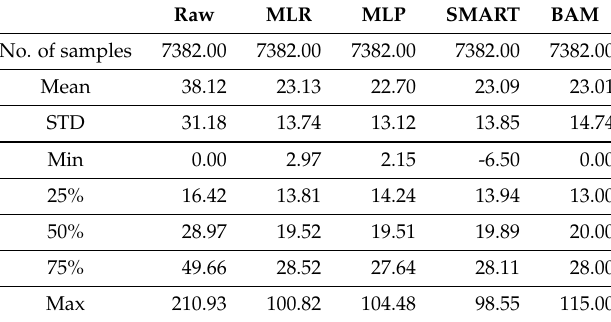
Table A4. Descriptive statistic summary of low-cost sensor and governmental BAM (after calibration).